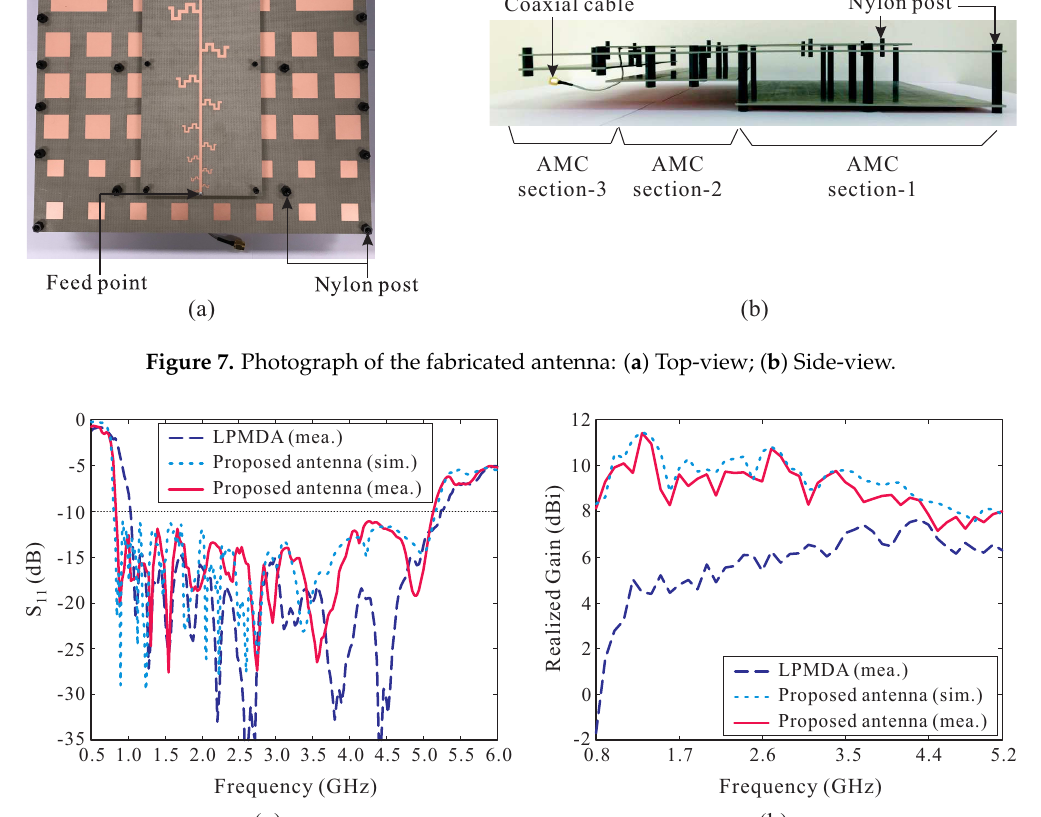
Figure 8. Performance of the proposed antenna: ( a ) Reflection coefficients; ( b ) Realized